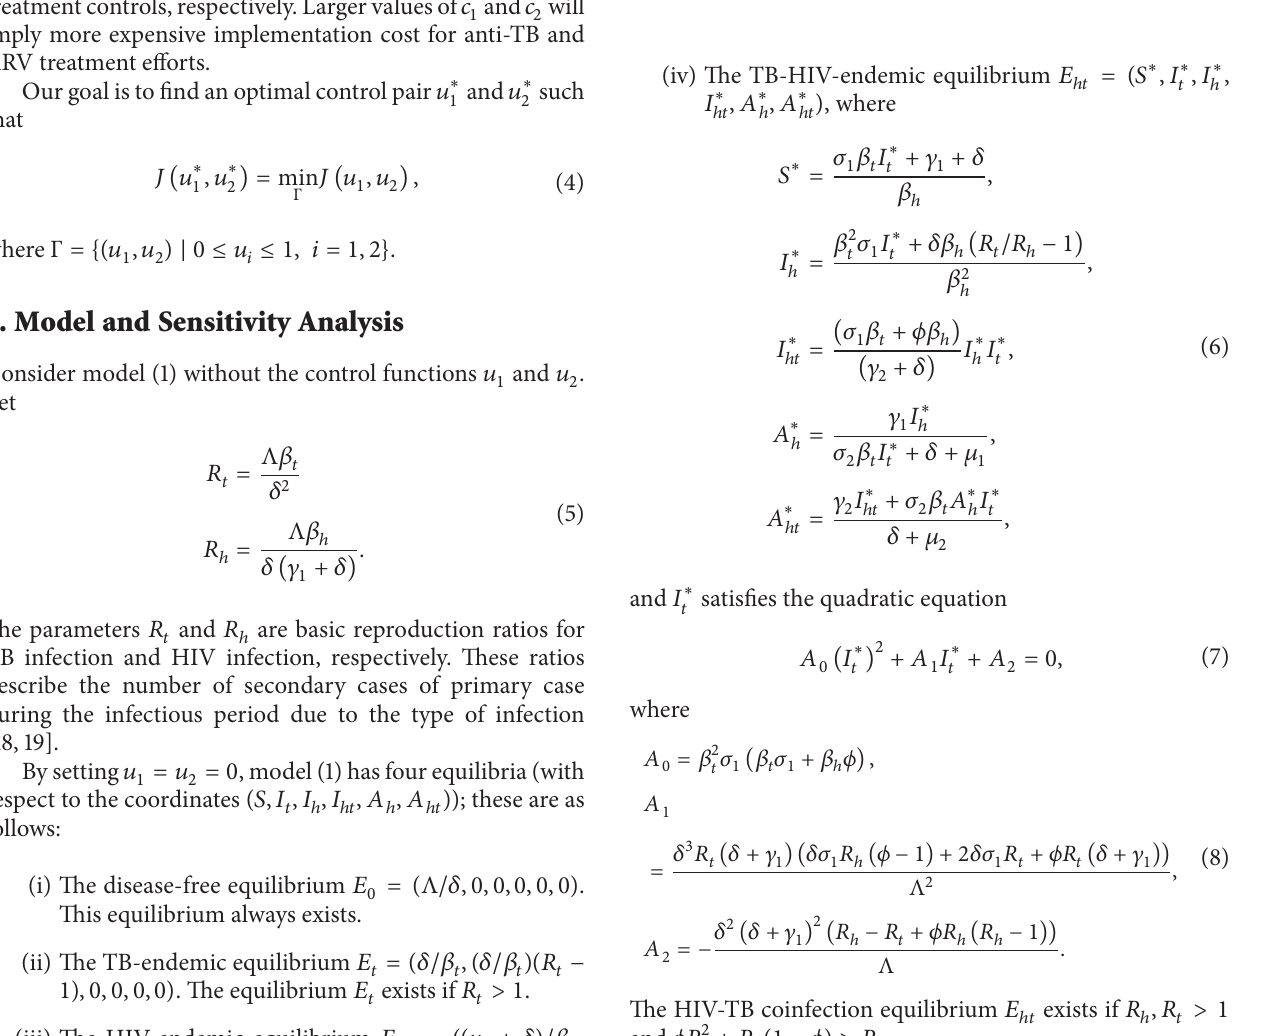
Figure 2: The diagram of equilibria with respect to 𝑅 ℎ and 𝑅 𝑡